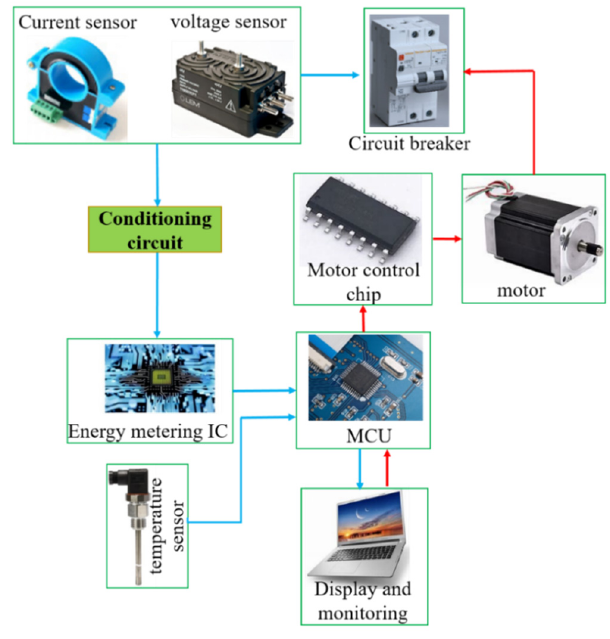
Figure 7. Diagram of hardware